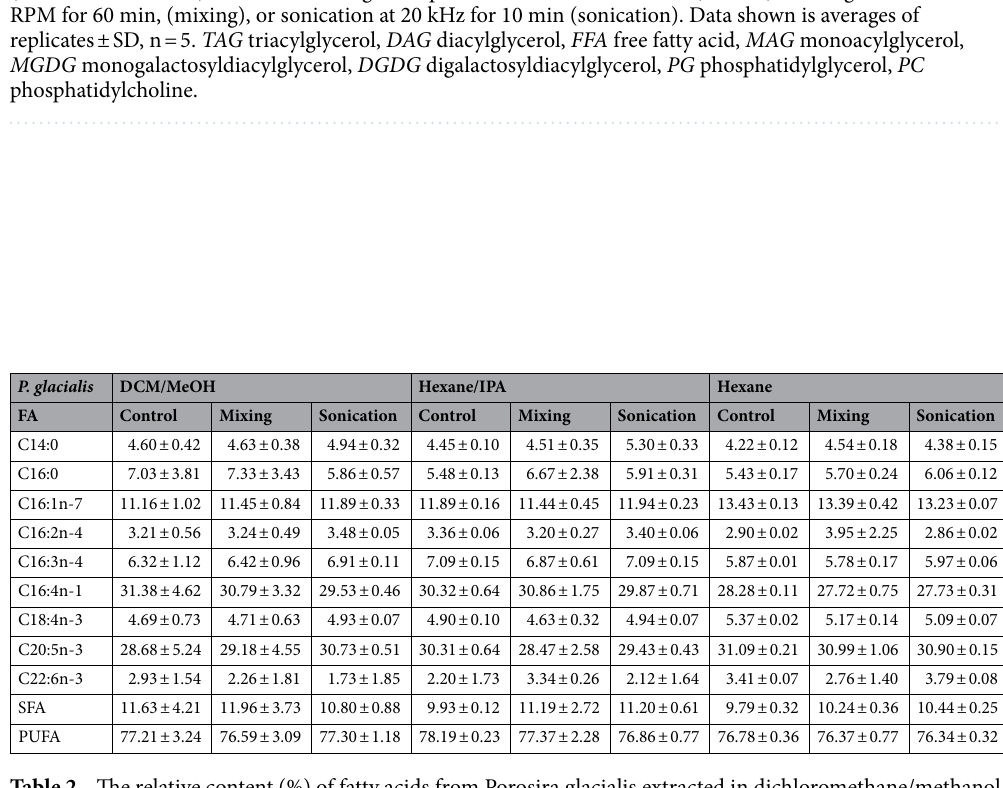
Table 2. The relative content (%) of fatty acids from Porosira glacialis extracted in dichloromethane/methanol (2:1 v/v; DCM/MeOH), hexane/isopropanol (2:1 v/v; hexane/IPA) and hexane, using three pre-treatments; no treatment (control), shaking at 1000 RPM for 60 min, (mixing), or sonication at 20 kHz for 10 min (sonication). Data shown is averages of replicates ± SD, n = 5. SFA saturated fatty acids, PUFA polyunsaturated fatty